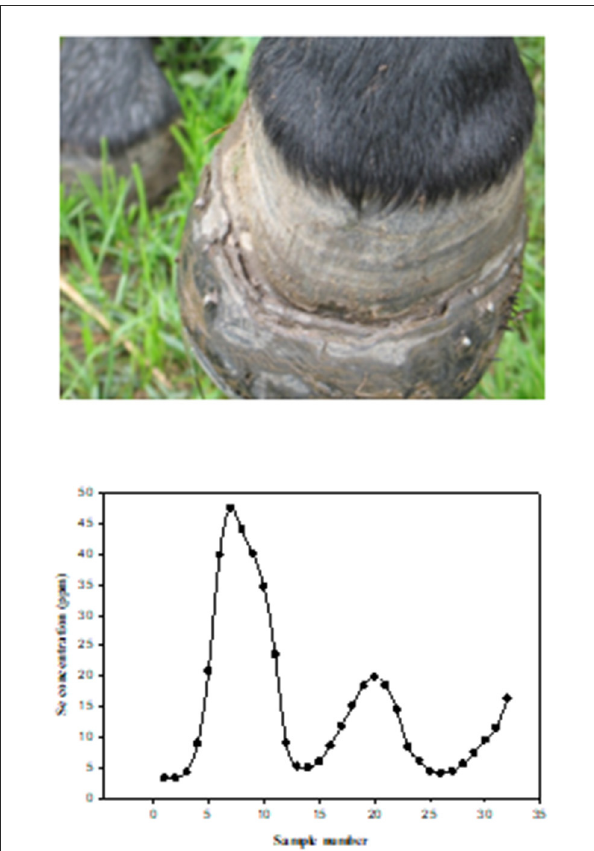
FIGURE8 Photograph of left front hoof of a horse chronically poisoned on selenium, seven months after being removed from the pasture containing high selenium forage and water. Figure 2B. Selenium (Se) concentrations in tail segments (2.5cm), from a horse that grazed in a pasture with high Se forages and water. The hair segments were numbered sequentially with the most recent growth (closest to skin) being number 1. The horse grazed in the pasture from approximately May 15th to November 15th for three consecutive years